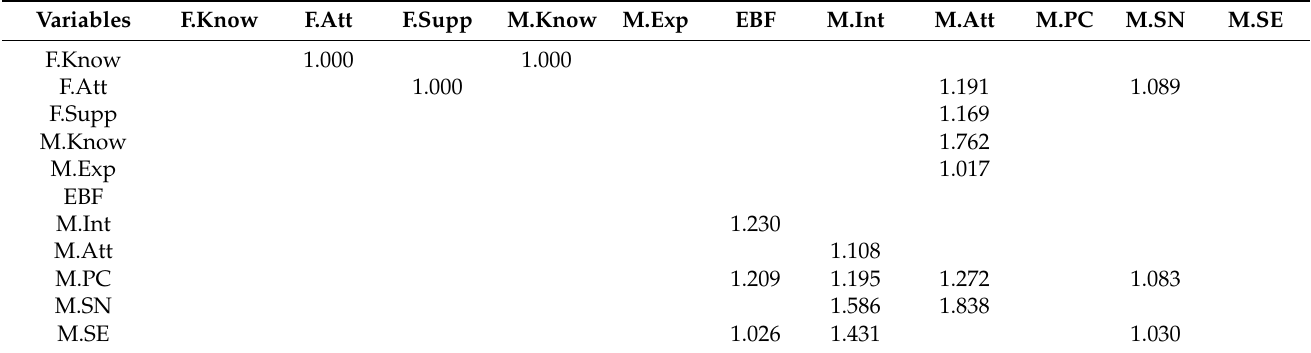
Table A4. Variance influential factor (VIF) of the